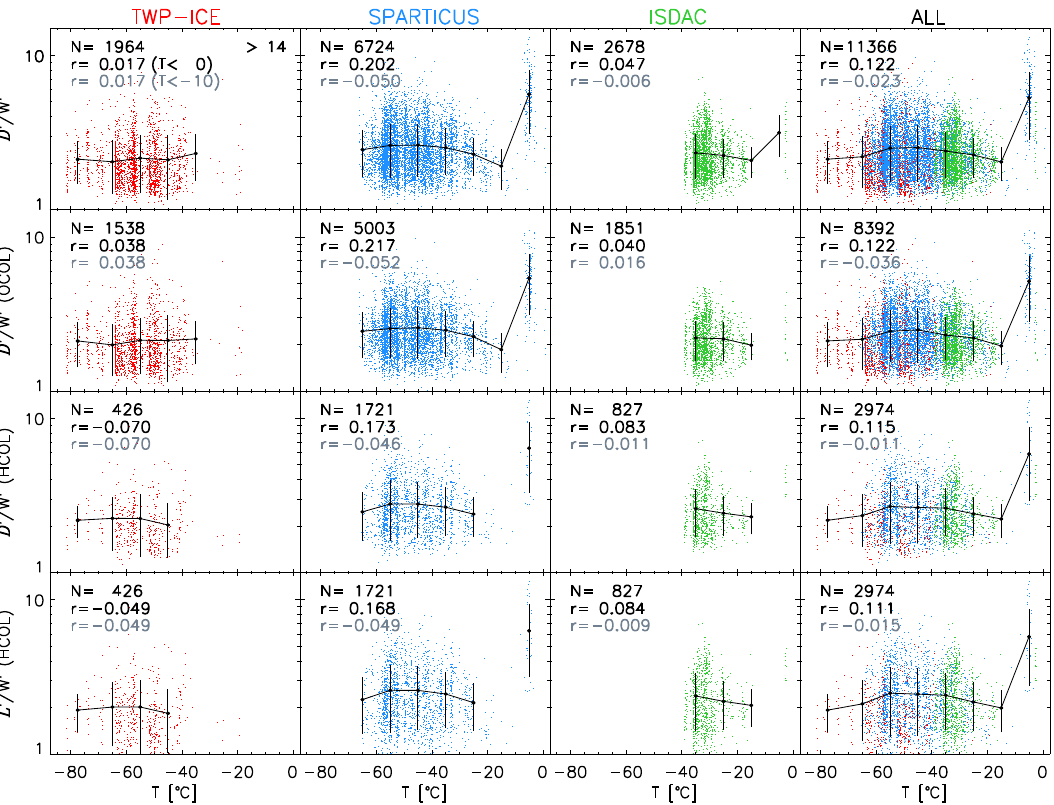
Figure 12. The projected aspect ratio ( D (cid:48) /W (cid:48) ) of all columns (top row), oriented columns (second row, OCOL), and horizontal columns (third row, HCOL) as a function of temperature. The bottom row shows L (cid:48) /W (cid:48) of horizontal columns. The mean and standard deviation for each temperature range are shown when more than 14 data points are available in the given temperature bin. Correlation coefficients ( r ) for − 85 < T < 0 ◦ C (black) and for − 85 < T < − 10 ◦ C (gray) are embedded in each